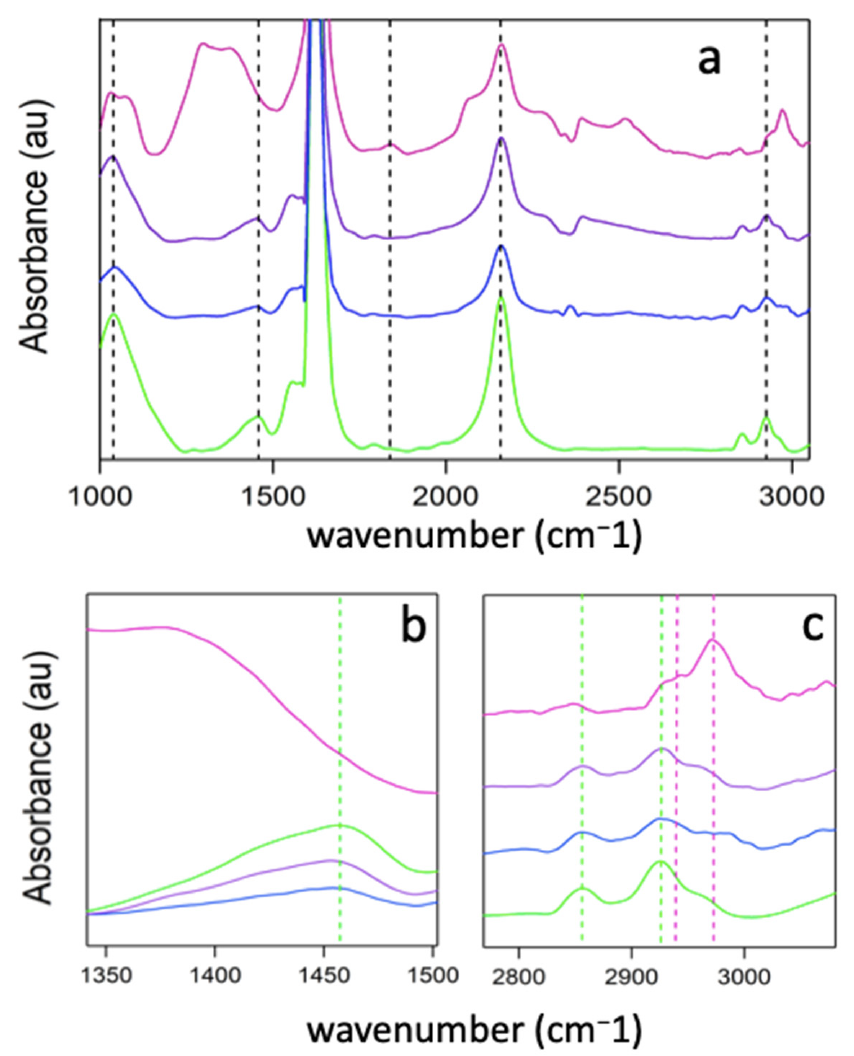
Figure 6. Infrared absorption spectra (panel ( a )) in the region of CH stretching vibrations. Inlet (green line), Effluent from secondary settling (blue line), Effluent from primary settling (violet line), Sludge from secondary settling (magenta line). Highlight of the spectral regions of the CH vibration (panel ( b , c )).